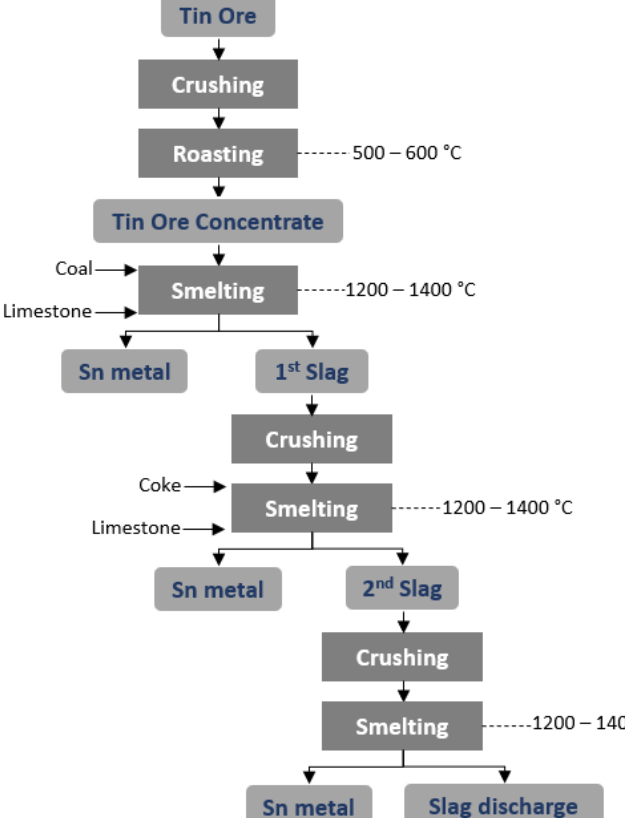
Figure 3. Tin smelting process (adapted from